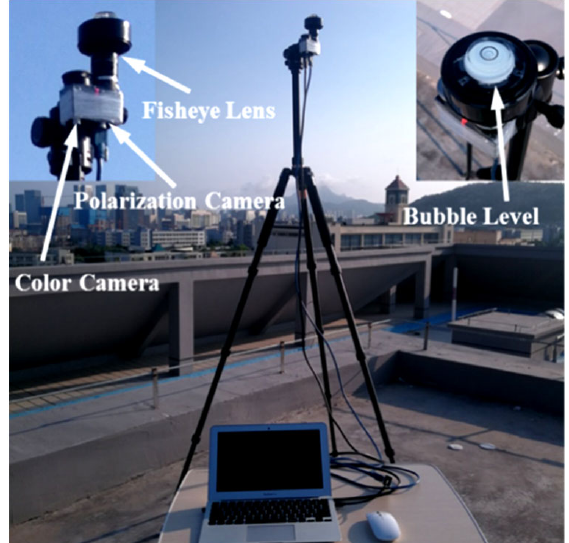
and we expect to present a more detailed analysis in the future. Figure 4 shows four real shots of all the weather conditions.